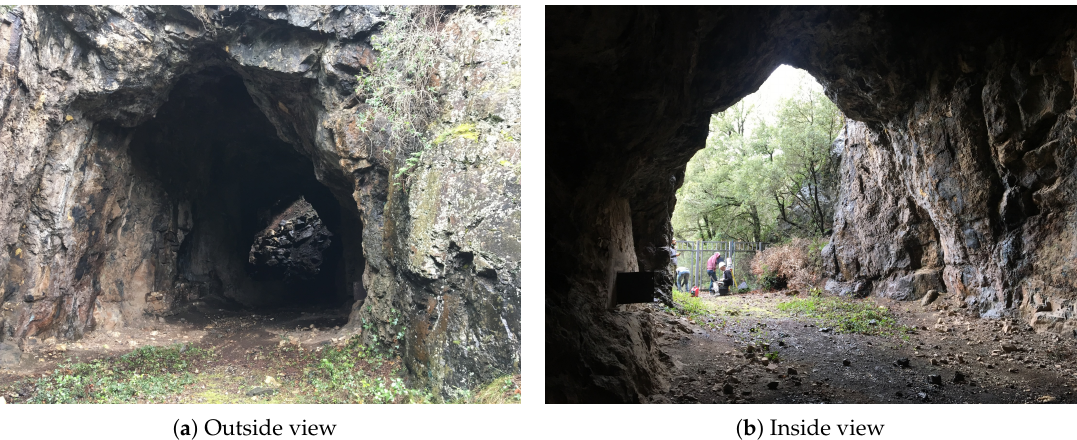
Figure 2. Pictures of the Gran Cava. ( a ) From the outside view, one can see the light from the exit at the end of the cavity where there is a vertical opening. ( b ) In the picture from the inside of the quarry, the authors can be spotted working on the laser scanner survey of the